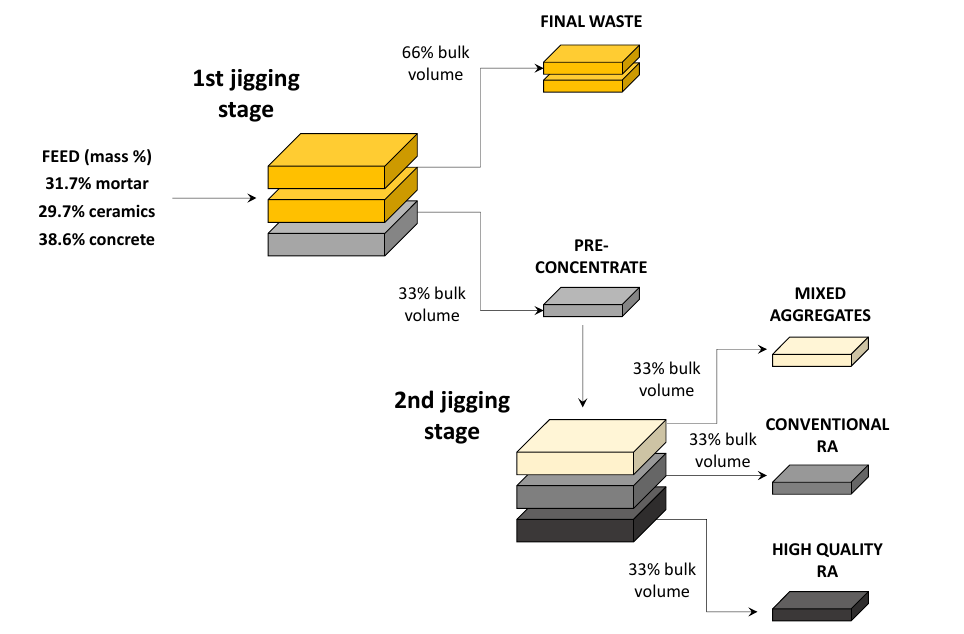
Figure 3. Scheme of jigging tests and product streams.